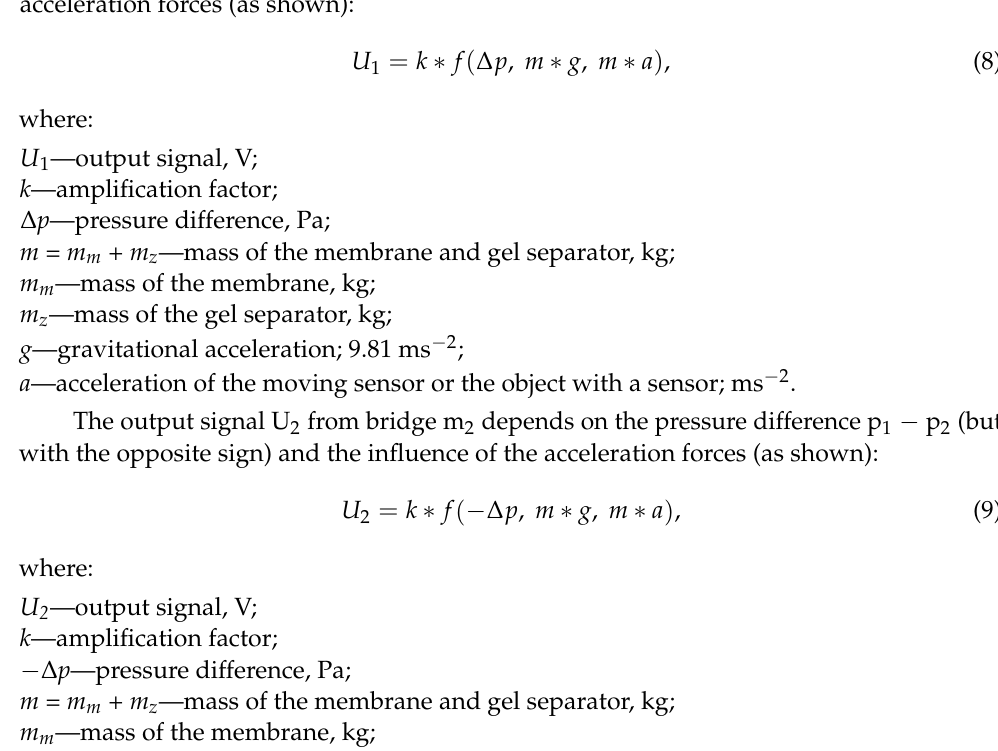
12 of 23 Figure 10. Waveforms of the experimental values of acceleration (a), pressure (p), and output signal (U out ) for dynamic acceleration with vibrations and with an amplitude of 5 g, frequency of f = 10 Hz, and pressure excitation of p = 5 Pa. In this system con fi guration, the output signal should have been 5 Pa because of the applied reference pressure at the transmi tt er inputs. The values on the U out curve varied from U out max = 76 Pa to U out min = − 66 Pa, resulting in an RMS value of U o(Rms) = 50.45 Pa. The output signal was a highly modulated harmonic signal that was ten times the measured actual pressure. The series of experiments for the various excitations of the accelerations and frequencies con fi rmed that the sensors reacted to accelerations to which they were subjected on the moving objects, therefore making measurements of particularly low pressures impossible. A relatively small level of acceleration was analyzed, and such an acceleration (1 g) may occur for a vibrating structure on which a pressure measurement is performed or for the variability of the fl ight parameters of an aircraft (including popular unmanned aerial vehicles). Under such conditions and with the use of the analyzed measuring devices, pressure measurements can be questionable. 3. Acceleration-Insensitive Transducer Concept Research on the errors that are caused by acceleration resulted in the proposal of a measurement methodology that utilized a hybrid system that consisted of two transducers, where one performed the task of acceleration compensation (described in [2]). The next stage was to develop the geometry of the transducer that was based on a double-membrane structure and was dedicated to be made piezoresistive with MEMS technology (as shown in Figure 11).